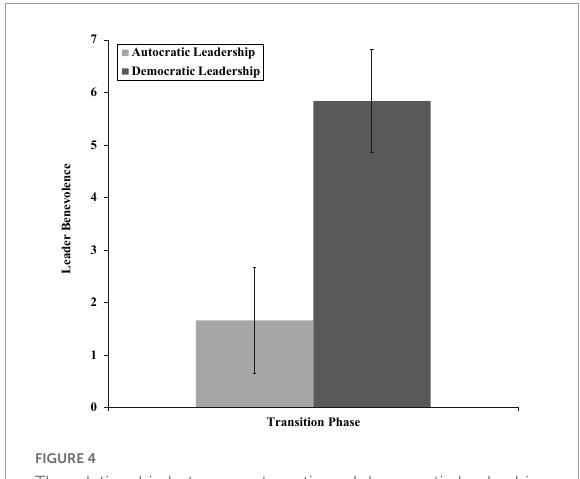
FIGURE4 The relationship between autocratic and democratic leadership and leader benevolence for the transition phase (Study